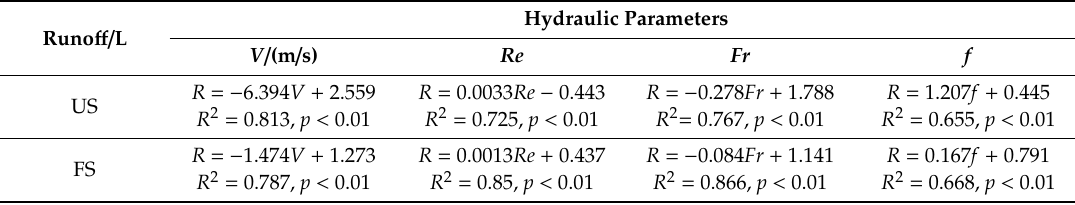
Table 8. Correlation between runo ff rate with flow velocity and hydraulic